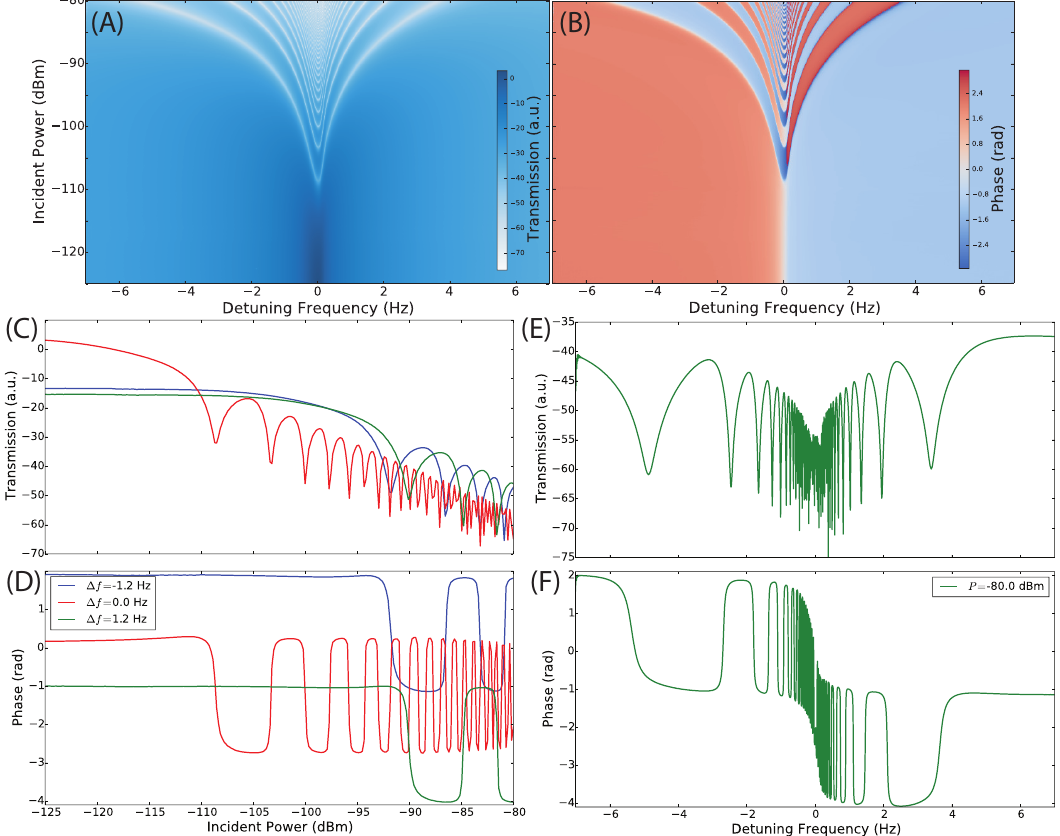
Figure 3. Top: Amplitude ( A ) and Phase ( B ) response of the series system as a function of the incident power in the vicinity of the 5th overtones of the A (quasi-longitudinal) mode (15.732444 MHz). Bottom Left: Amplitude ( C ) and Phase ( D ) response as a function of power for three specific values of the detuning frequency from the data represented on the left. Bottom Right: Amplitude ( E ) and Phase ( F ) response for three specific values of the incident power from the data represented on the